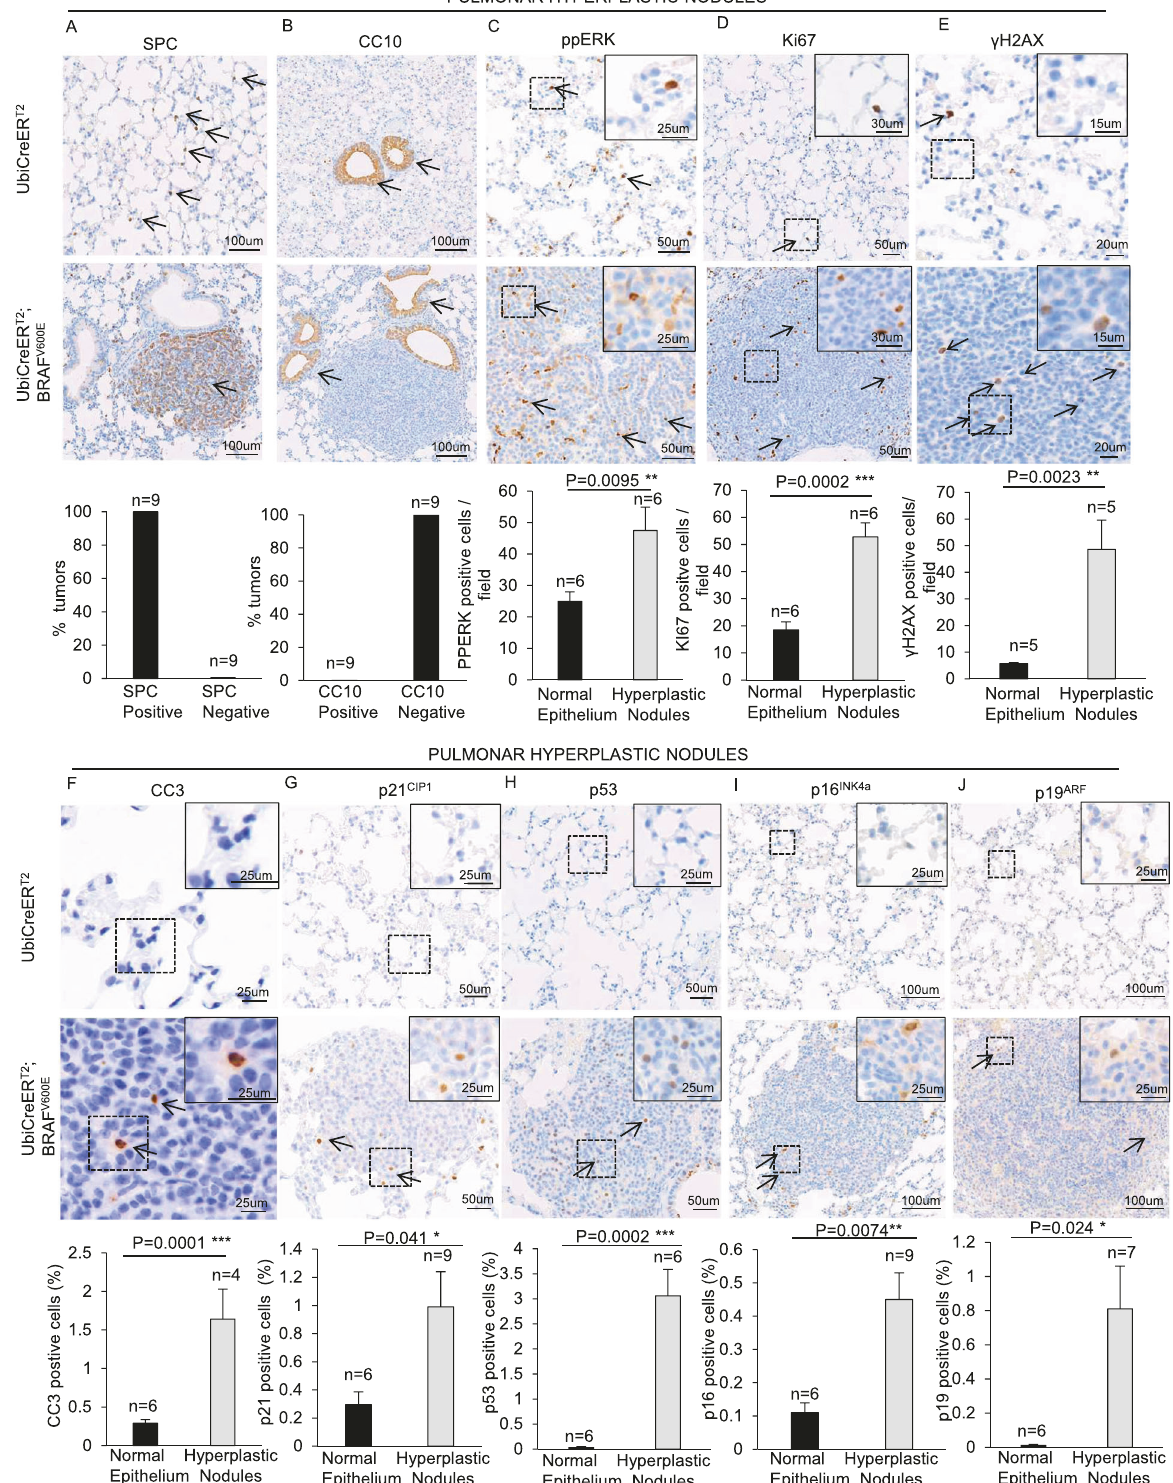
Fig. 3 Effects of expression of BRAF V600E in hyperplastic nodules. Representative images (top) and quanti fi cations (bottom) showing H&E staining, A SPC, B CC10, C ppERK, D Ki67, E γ H2AX, F CC3, G p21 CIP1 , H p53, I p16 INK4a , J p19 ARF immunostainings in lung sections from BRAF V600E and control mice. Quanti fi cations were performed on four different random areas of at least four hyperplastic nodules sections and four different random areas of uninduced alveolar parenchyma. Data are expressed as mean ± SEM; n represents respectively the number of animals per group in “ normal epithelium ” samples and the number of tumors in the “ hyperplastic nodules ” samples. For each condition at least 4 mice were used. * P < 0.05; ** P < 0.01; *** P < 0.001, ns = not signi fi cant (T Student ’ s test unpaired). Arrows point to selected positive cells for the indicated marker. Insets: magni fi cations of areas inside dashed squares.